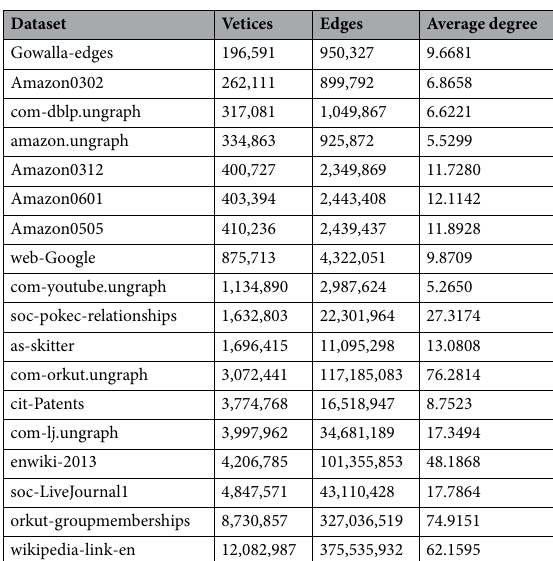
Table 1. Details of datasets.